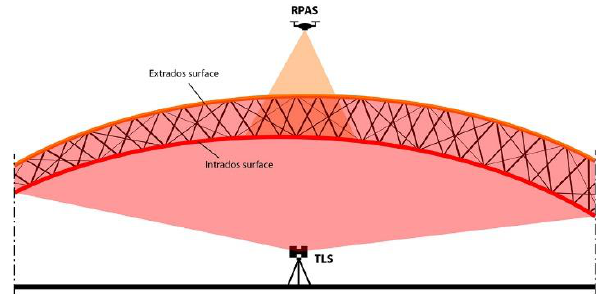
Figure 5: Intervisibility scheme between TLS and RPAS. Some project prerequisites have influenced the operative step.